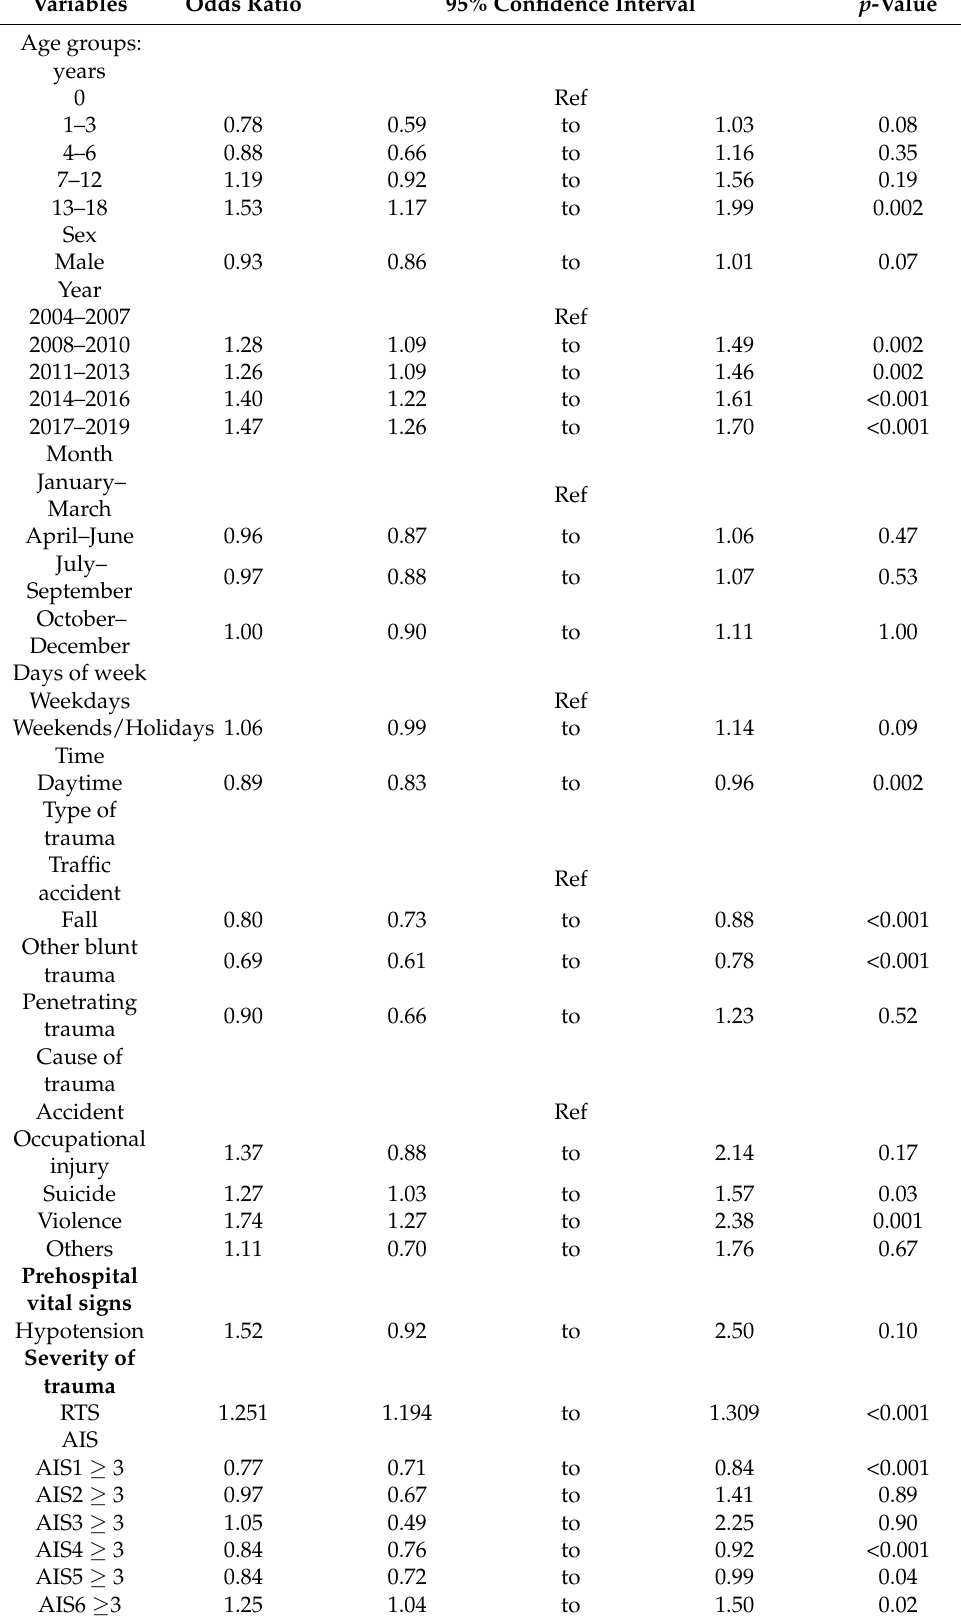
Table 3. Multivariable logistic regression analysis with multiple imputation for missing